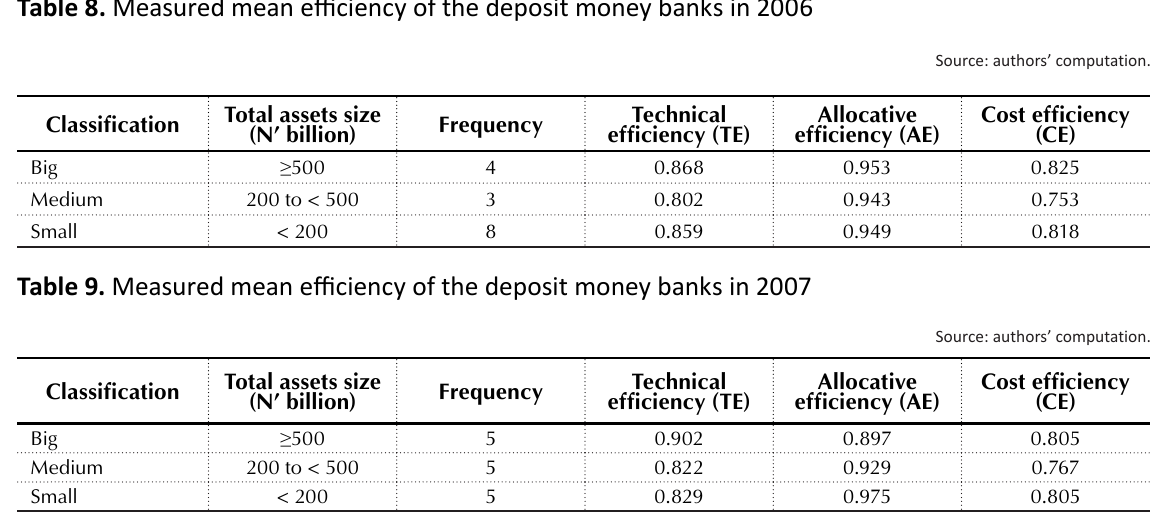
Table 8. Measured mean efficiency of the deposit money banks in 2006